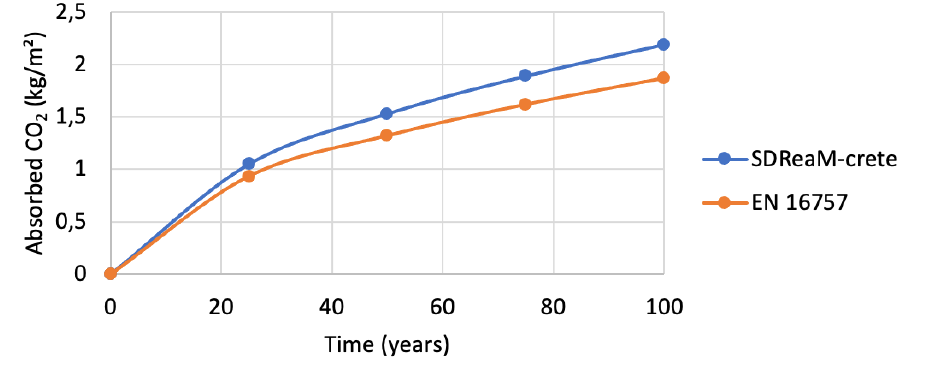
Figure 4. Absorbed carbon dioxide calculated with two models and two